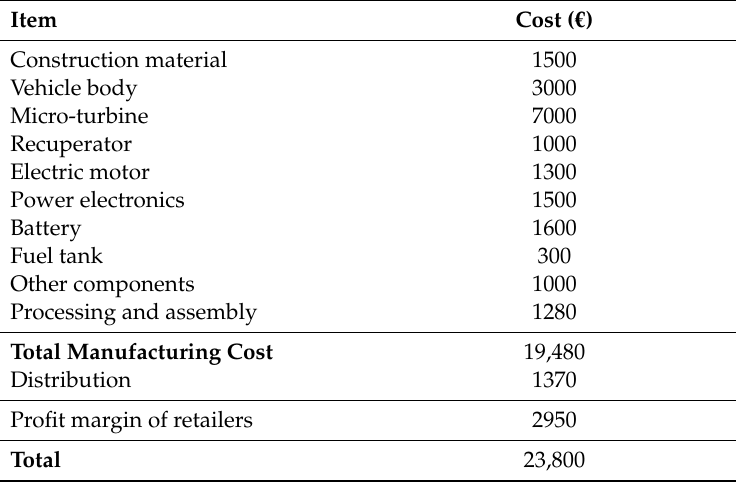
Table 33. Allocation